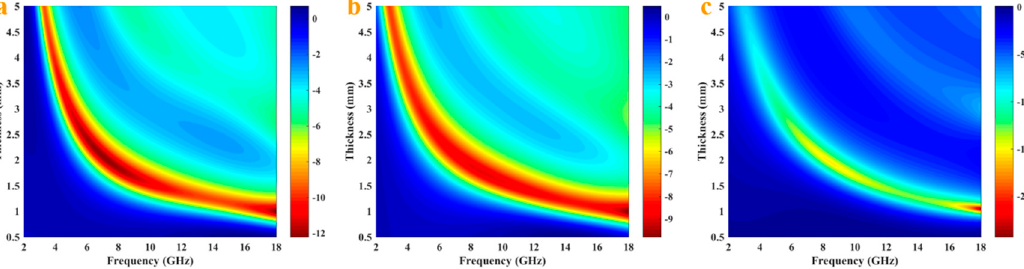
Figure 9. The 2D calculated reflection loss (RL) value maps of as-prepared composites with different PIP cycle numbers within 0.5–5 mm and 2–18 GHz: ( a – c ) one, two, and three PIP cycles.